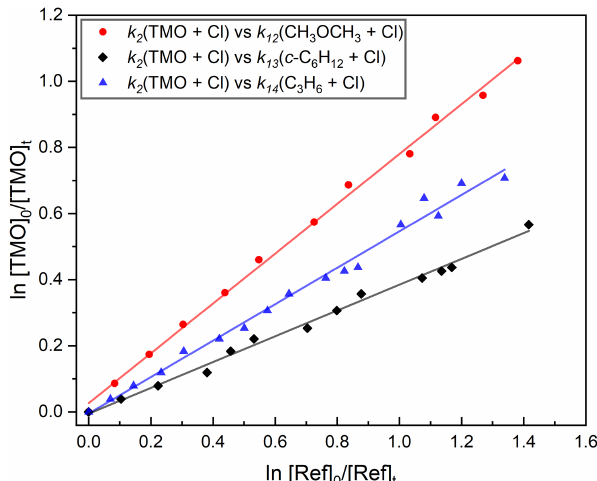
Figure 7. Exemplary relative rate plots, used to determine k 1 (296K) for OH + TMO (Reaction R1). The red circles corre- spond to use of CH 3 OCH 3 (Reaction R10) as reference and the black squares c − C 6 H 12 (Reaction R11). The solid lines are linear fits, with gradient values used (Eq. 3) in conjunction with literature data (Table 1) to obtain k 1 . Each experiment was repeated twice, and the full results, summarised in Table 3, were averaged to obtain